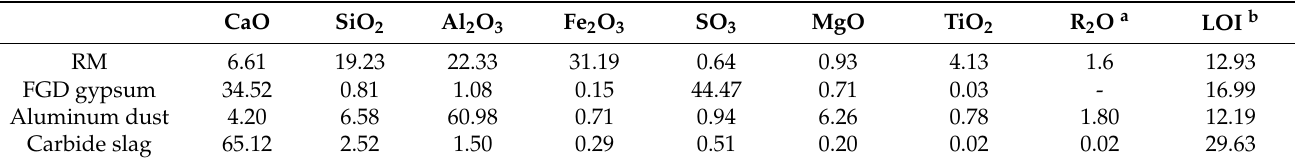
Table 2. Chemical composition of raw materials (wt.